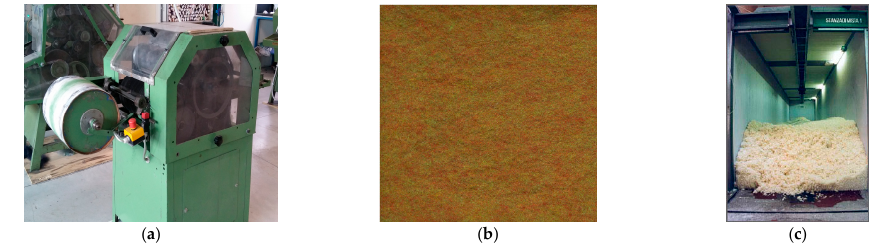
Figure 1. ( a ) Small drum carding machine used to create carded fabric samples to be inspected by colorists; ( b ) example of a carded fabric obtained by using the small drum carder; and ( c ) blow room where fibers are opened, cleared and mixed.